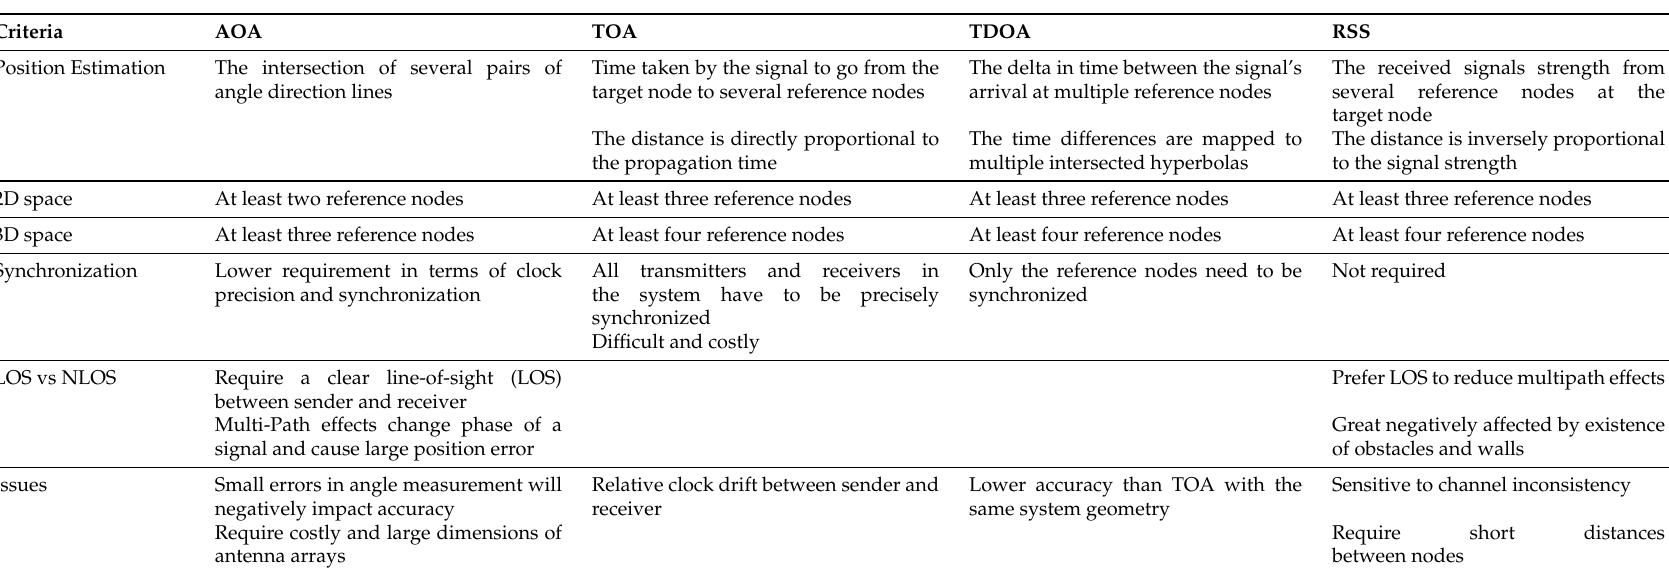
Table 8. Comparison of UWB